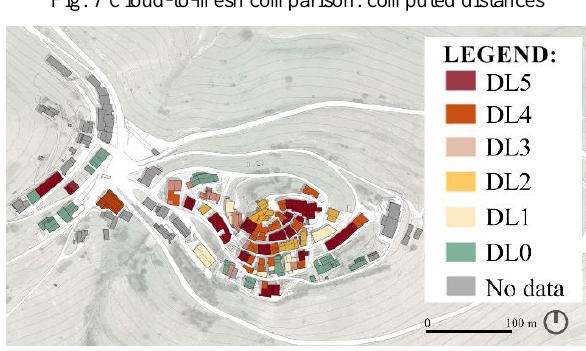
Fig. 7 Cloud-to-mesh comparison: computed distances